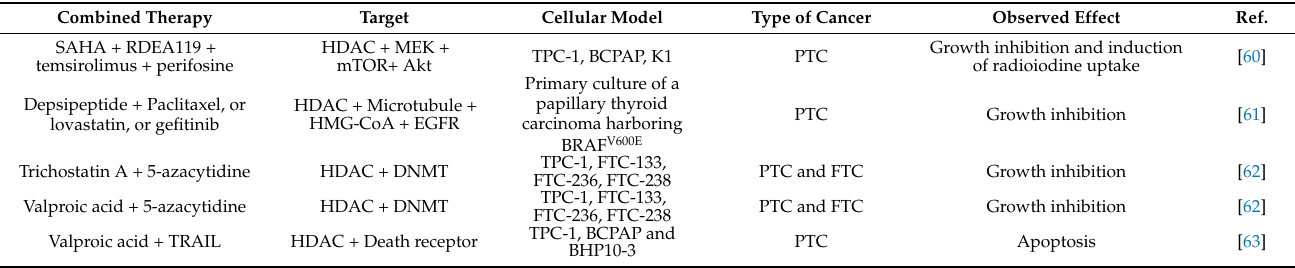
Table 3. In vitro studies on combined therapy in thyroid